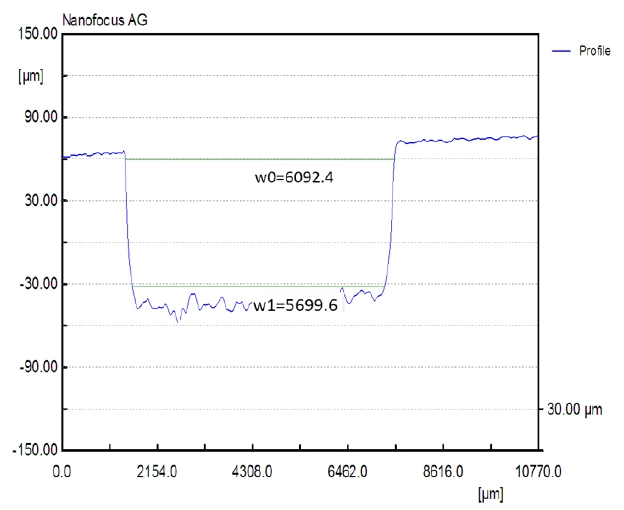
Figure 7. 2D Transverse profile and dimensions of R1 coolant tank.